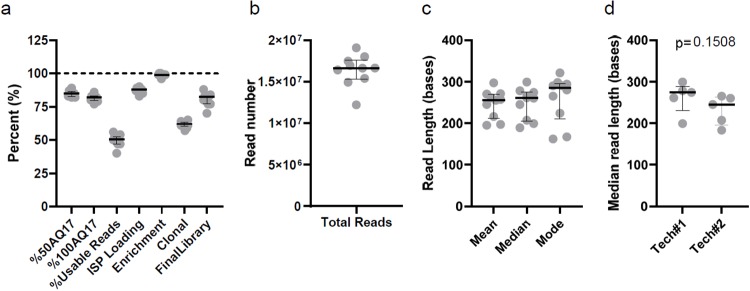
Distribution of run-level metrics from ten sequencing runs.a) Metrics for sequencing accuracy of test fragments (%50AQ17 and %100AQ17) and the percentage of reads usable for analysis. The latter is dependent on the percentages of ion-sphere particle (ISP) loading, template-positive ISP (enrichment), clonal ISP, and final library. b) Total reads usable for analysis. c) The mean, median, and mode of read lengths from 10 runs. d) The median read lengths stratified by technologists. Lines are medians and interquartile ranges.